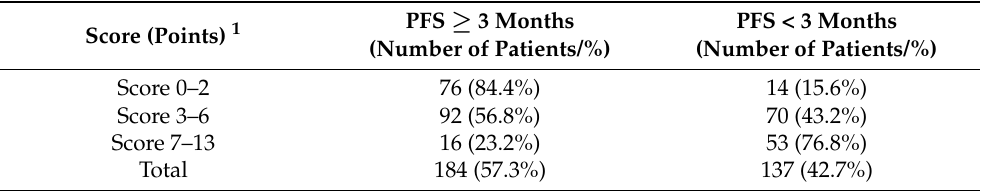
Table 3. Proposed prognostic score model for early progression in patients receiving 1L mono-